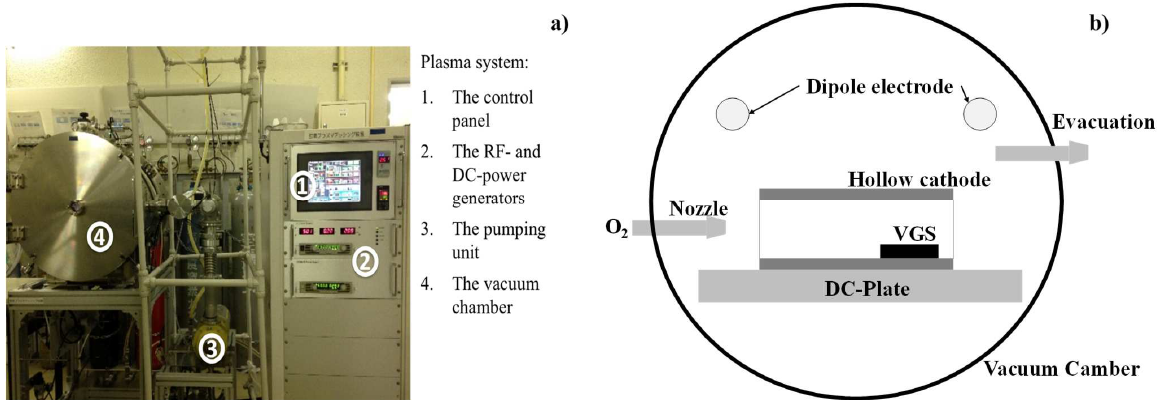
Figure 3. Plasma etching system for micro texturing into the graphene substrate. ( a ) Overall view of the etching system, and ( b ) schematic view of the experimental setup for etching.